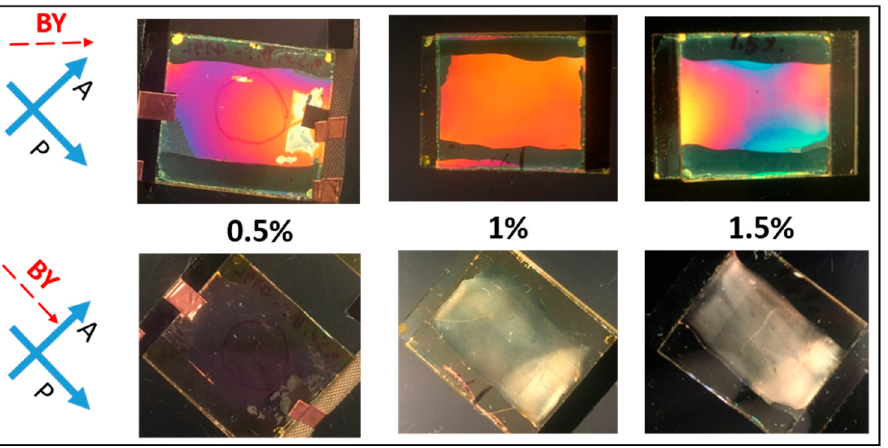
Figure 2. Observation of cells between crossed polarizers after UV polymerization. Cells were filled with mixtures of different RM (Bis-MA) concentration (0.5%, 1%, or 1.5%) in LC (ZLI-4792). with mixtures of different RM (Bis-MA) concentration (0.5%, 1%, or 1.5%) in LC